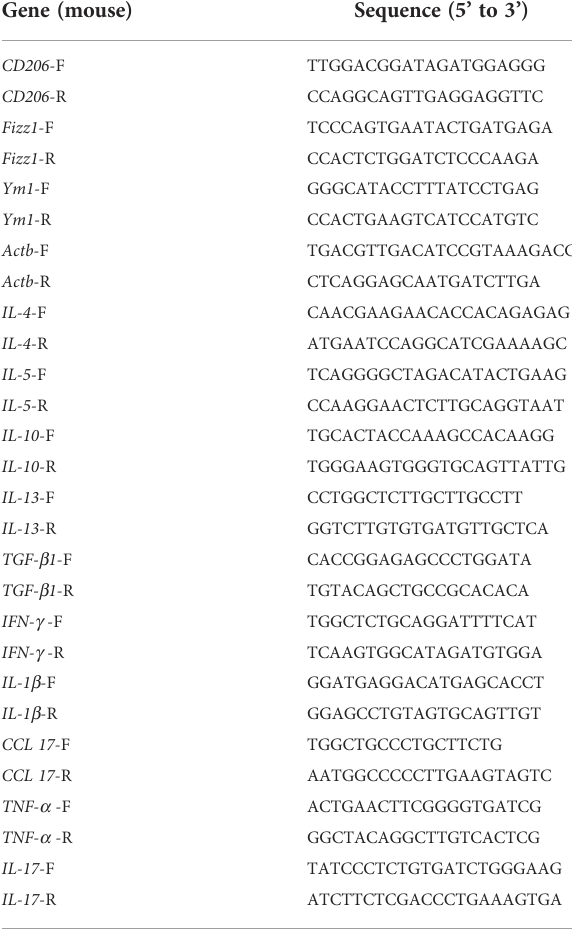
TABLE 3 Primer pairs used for quantitative real-time